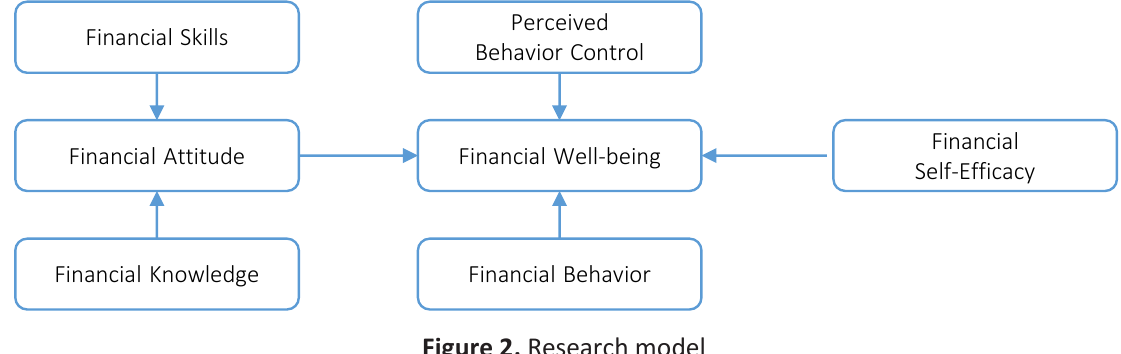
Figure 2. Research